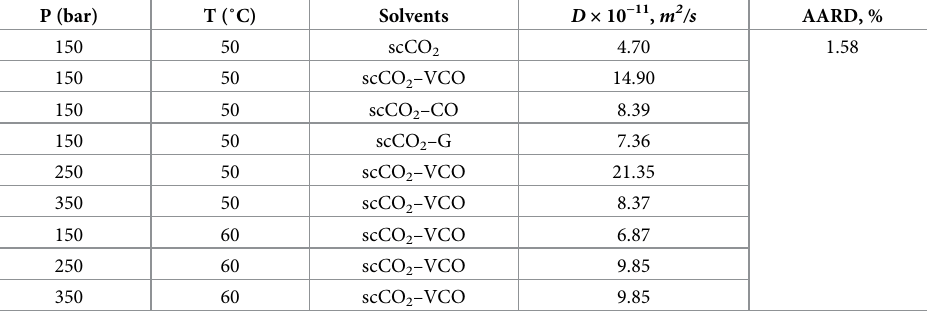
20% mass ratio edible oil to propolis. VCO: virgin coconut oil; CO: corn oil; G: ghee; scCO 2 : supercritical carbon dioxide; supercritical carbon dioxide: 150 bar and